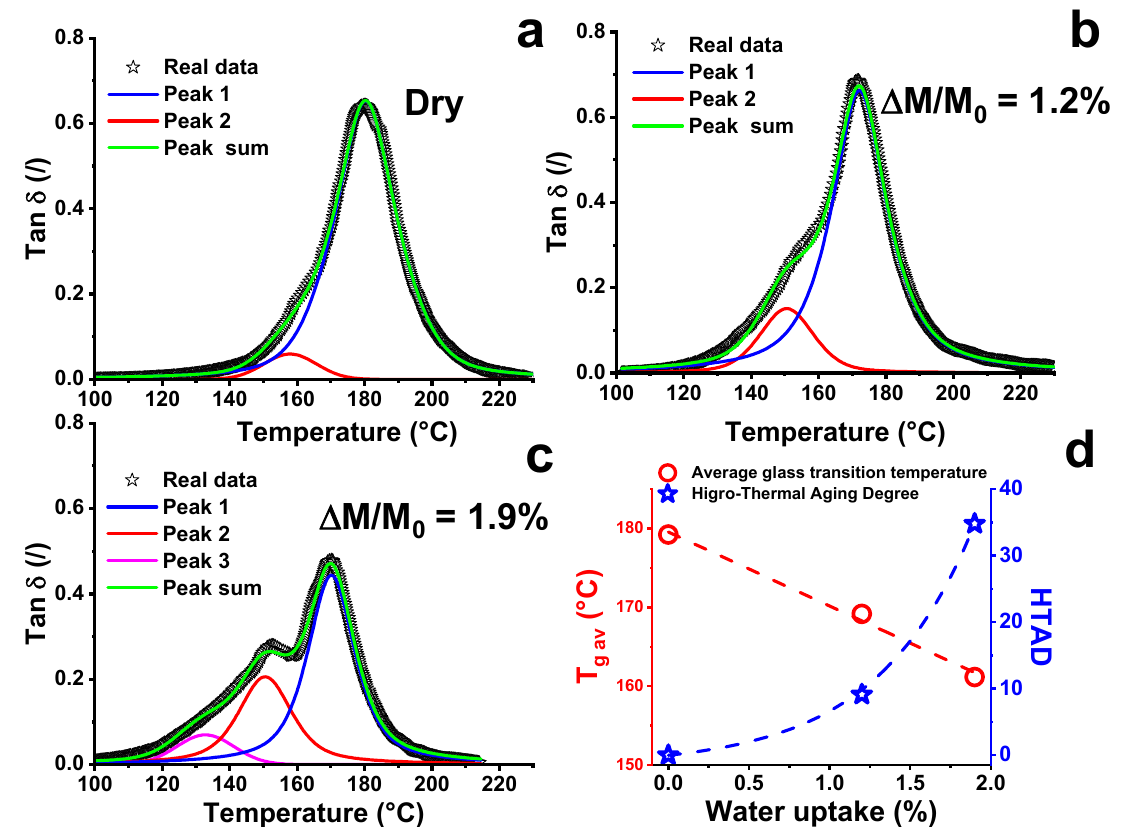
Figure 3. Master curve of the multiple α i -relaxations of the tan δ relating to the composite under different conditions: ( a ) dry; ( b ) water amount of 1.2%; ( c ) water amount of 1.9%; ( d ) average value of the glass transition temperature (T g av .) and Hydro-Thermal Aging Degree (HTAD) as a function of water amount.